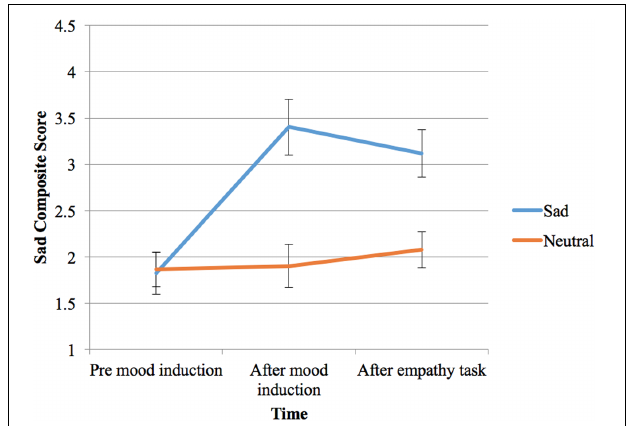
FIGURE 1 | Participant sample one’s self-reported mood (composite score from 0 to 10, 0 = not sad at all and extremely happy; 10 = not happy at all and extremely sad) before and after two types of mood induction (sad or neutral), and at the end of the empathy task (bars shown are standard errors).